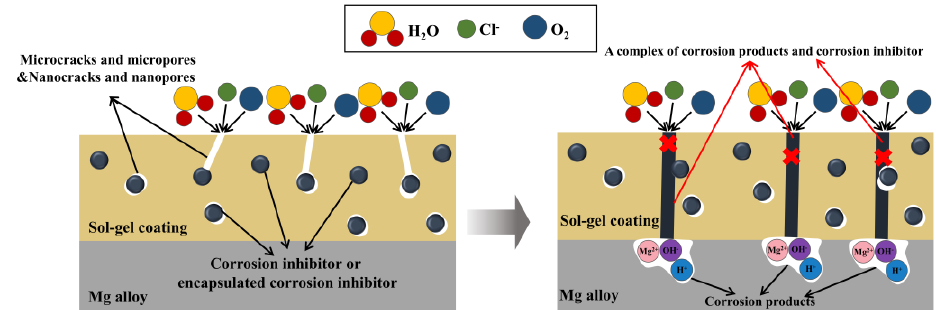
Figure 4. The schematic diagram of sol-gel coating containing corrosion